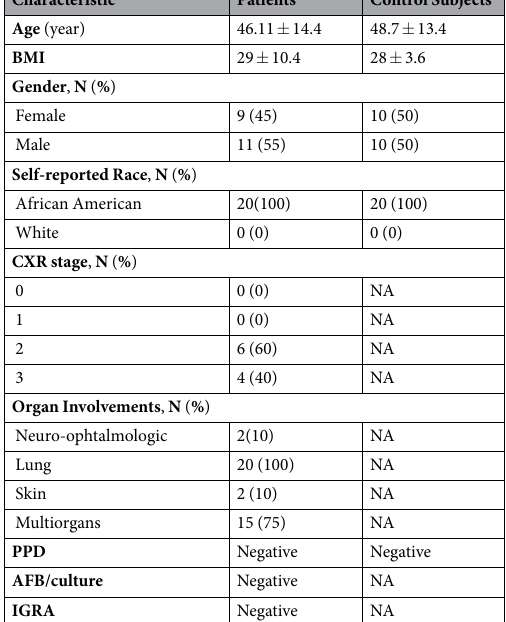
Table 1. Subject Demographics Definition of abbreviations: BMI = body mass index, CXR = chest X-ray, NA = not applicable, PPD = purified protein derivative, AFB = acid-fast bacilli, IGRA = interferon gamma release